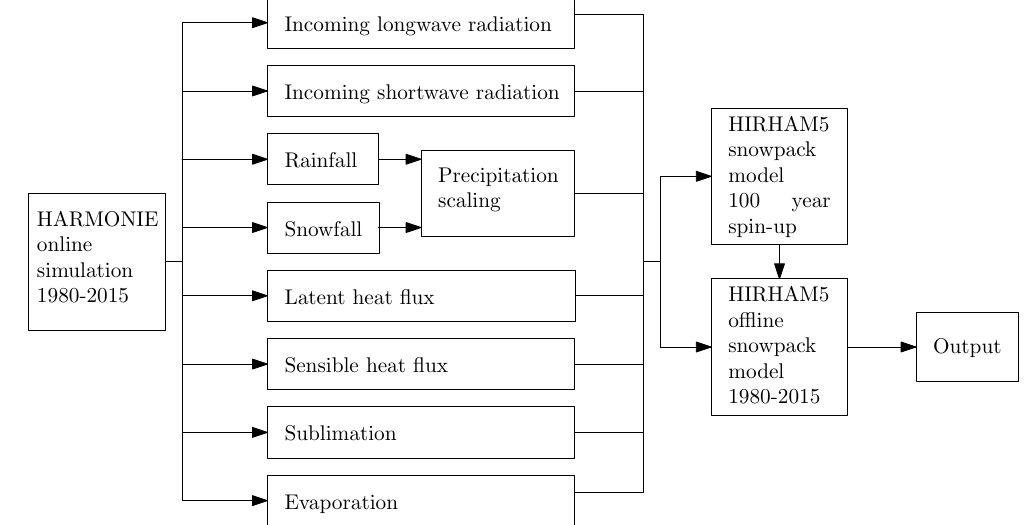
Figure 2. A schematic diagram of the coupling of HARMONIE-AROME and HIRHAM5. The precipitation scaling is discussed in Section